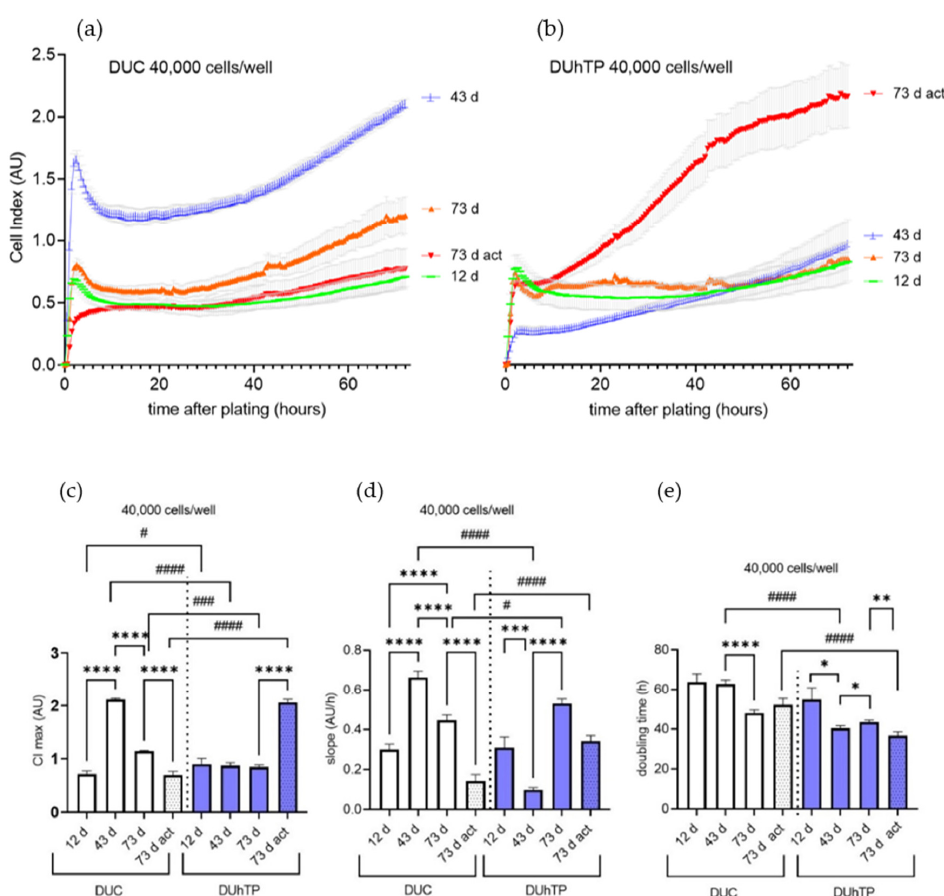
Figure 4. Cultured pools of MPC/SATC from male DUC (left and in white; pools ( n = 3–4) represent: 12 d: 6 mice, 43 d: 16 mice, 73 d: 16 mice, 73 d act: 12 mice) and DUhTP animals (right and in blue; pools ( n = 3) represent: 43 d: 9 mice, 12 d, 73 d, and 73 d act: 8 mice) were derived from sedentary animals at the age of 12, 43, 73 days ( d ) and physically active (act) animals at the age of 73 days. The impedance-based xCELLigence system was used for real-time monitoring of adhesion and proliferation of SATC populations seeded at densities of 40,000 cells per well. Kinetic growth curves ( a , b ) of SATC were recorded for 72 h, and ( c ) the maximum cell index (CI max), ( d ) the slope during the adhesion period, and ( e ) doubling time (DT) were analyzed. DT was obtained during the logarithmic growth phase, while the slope was calculated ( ∆ CI/ ∆ time) during the adhesion period. The data are shown in histograms as means and SD. Significant line-specific differences (DUC vs. DUhTP mice) are separated by hashtags ( # p < 0.05, ### p < 0.001, #### p < 0.0001), while significant age-related or activity-related differences within each line are separated by asterisks (* p < 0.05, ** p < 0.01, *** p < 0.001, **** p < 0.0001). Compared with sedentary 73-day-old mice, voluntary activity led to decreased ( p < 0.0001) CImax (0.70 ± 0.07 AU) and slope (0.14 ± 0.03 AU/h) in DUC cells, whether CImax increased in DUhTP cells (CImax: 2.10 ± 0.06 vs. 0.84 ± 0.04 AU; p < 0.0001). In